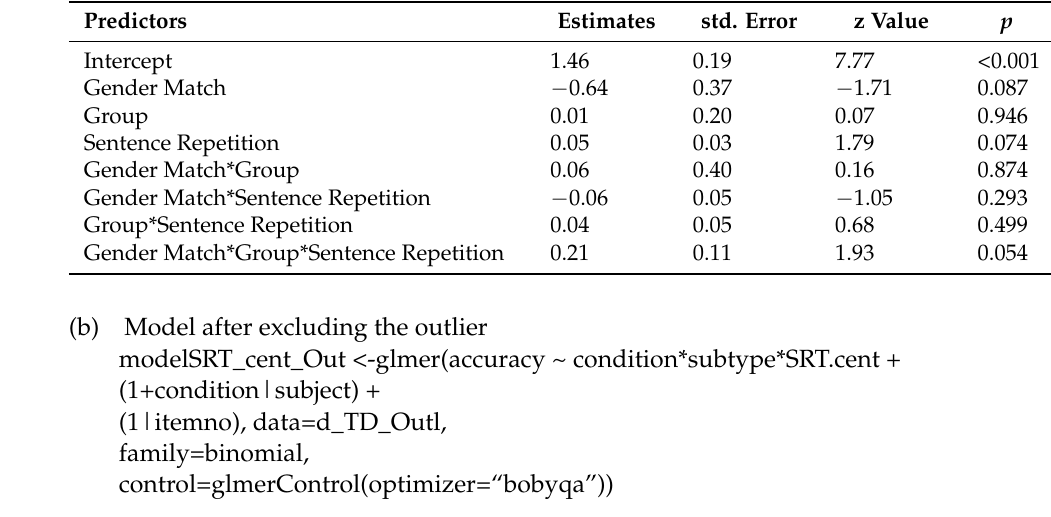
Table A3. Summary of the final model for accuracy and the effect of sentence repetition in the production task.